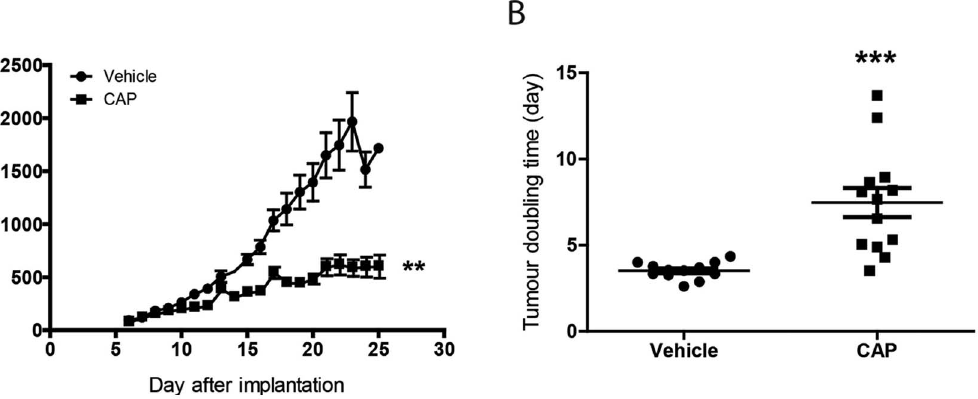
Figure 2. Anti-tumour effect of capecitabine in KPC allograft tumours. (A) Capecitabine efficacy in mice bearing K8484 allograft tumours. Animals received 755 mg/kg daily for 5 consecutive days per week for 3 weeks. Tumour volumes are represented as the mean 6 SEM of 12 vehicle- and 13 CAP-treated mice (**p , 0.01). (B) The tumour doubling time for each tumour (***p , 0.001).